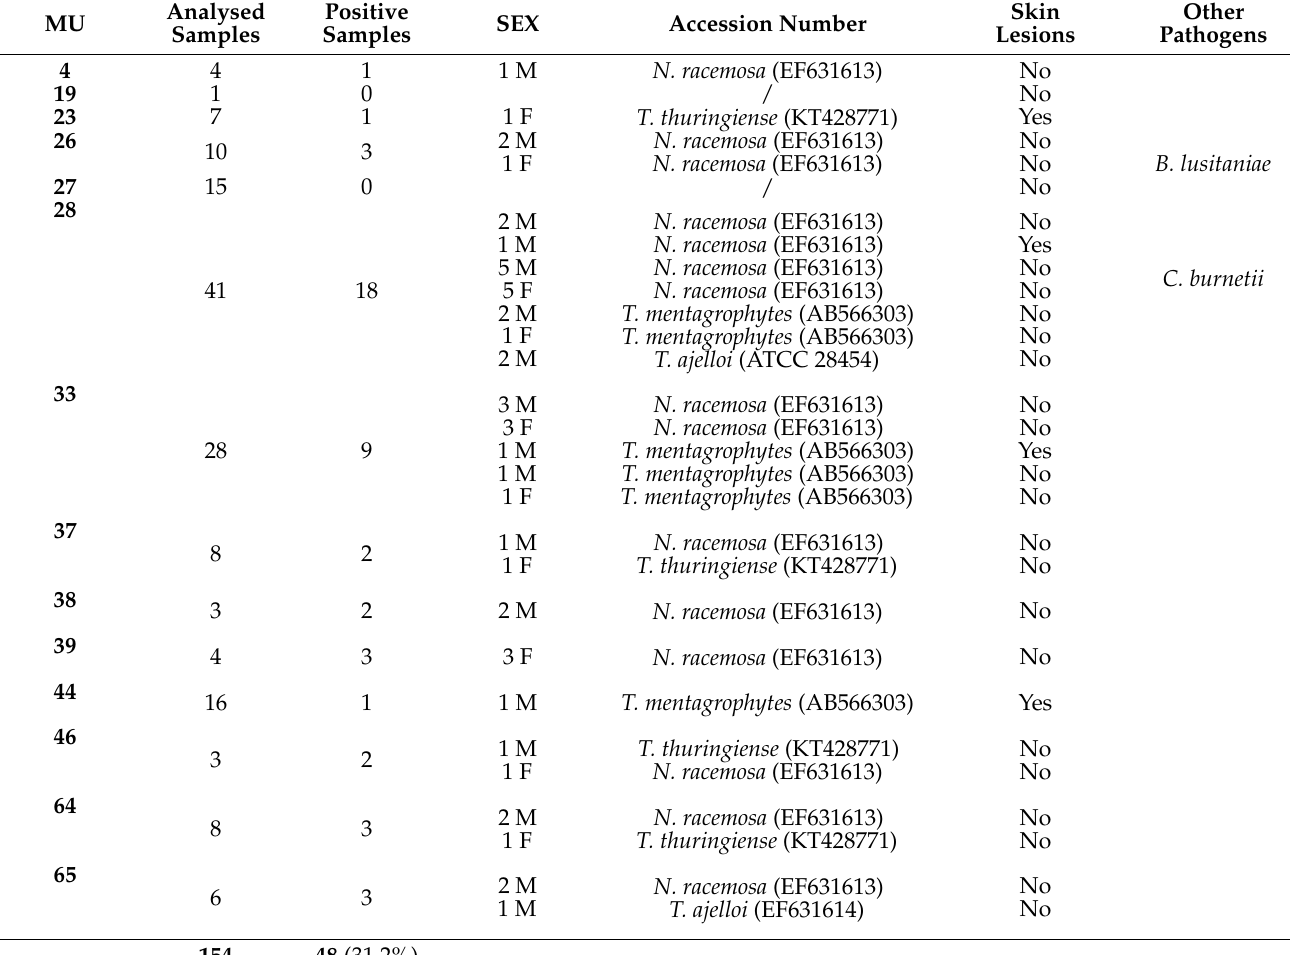
Table 2. Results and details of detected dermatophytes, related to the presence of other